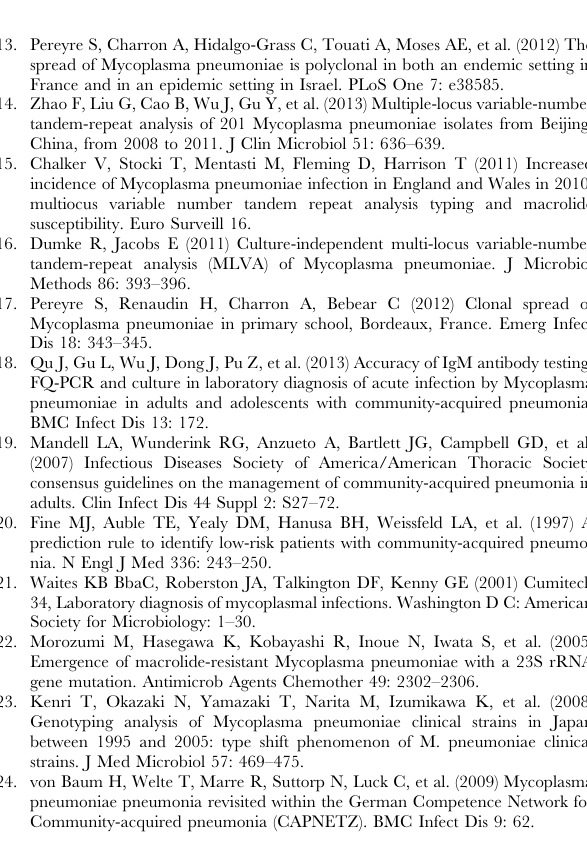
Table S1 In vitro activity of nine antimicrobials against 136 M. pneumoniae